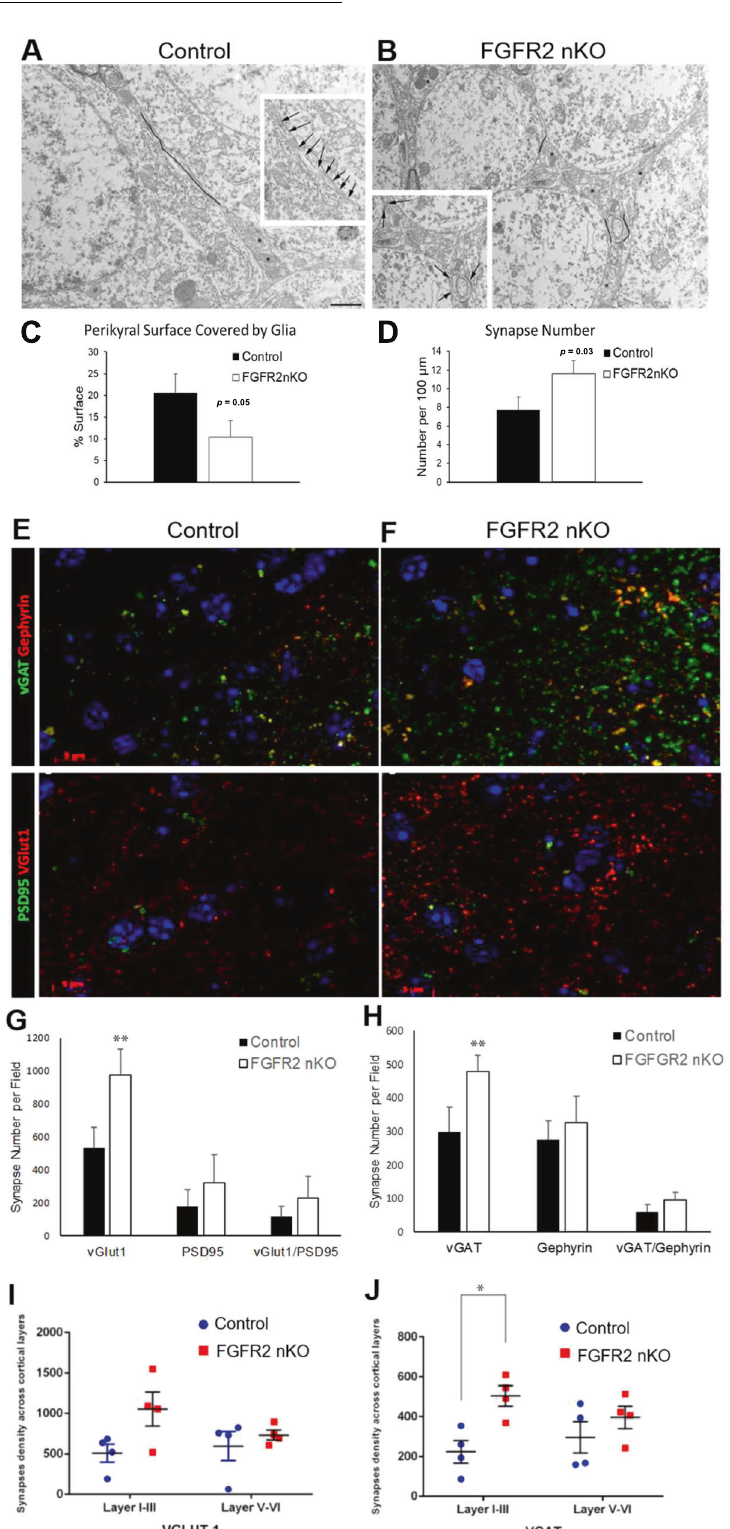
Fig. 4 Adult male mice early postnatally lacking FGFR driven by GFAP- CreER T2 (induced with neonatal tamoxifen injections P1-7) show reduced astrocyte processes in neuropil by electron microscopy. A – D Less glial coverage of perikaryal membrane (black lines) and more synapse number on the same membrane (asterisks) in FGFR2 nKO compared to control littermate mice in the hippocampus CA3 region (30 cells per genotype). N = 3,3. These mice also show increased density of pre-synaptic proteins assessed by immuno fl uorescence. E – H Greater number of puncta of vGLUT1 and vGAT per fi eld of analysis in lateral cortex. I , J Greater number of vGAT puncta in cortical layers I-III when evaluated separately from cortical layers IV-VI. N = 4,4; * p < 0.05, ** p < 0.01 two-tailed Student ’ s t-tests or ANOVA. Means and SEM